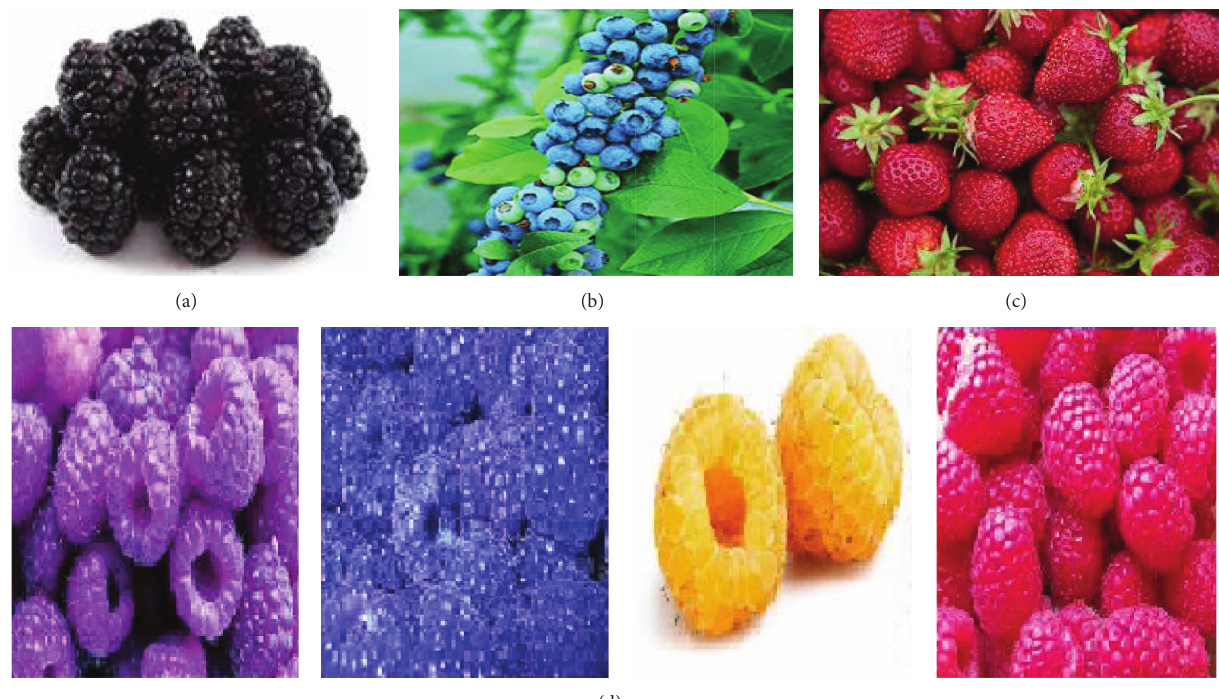
Figure 2: Structure of nutraceutical fruits for brain health: (a) blackberries, (b) blueberries, (c) strawberries, and (d) raspberries (purple, blue, yellow, and